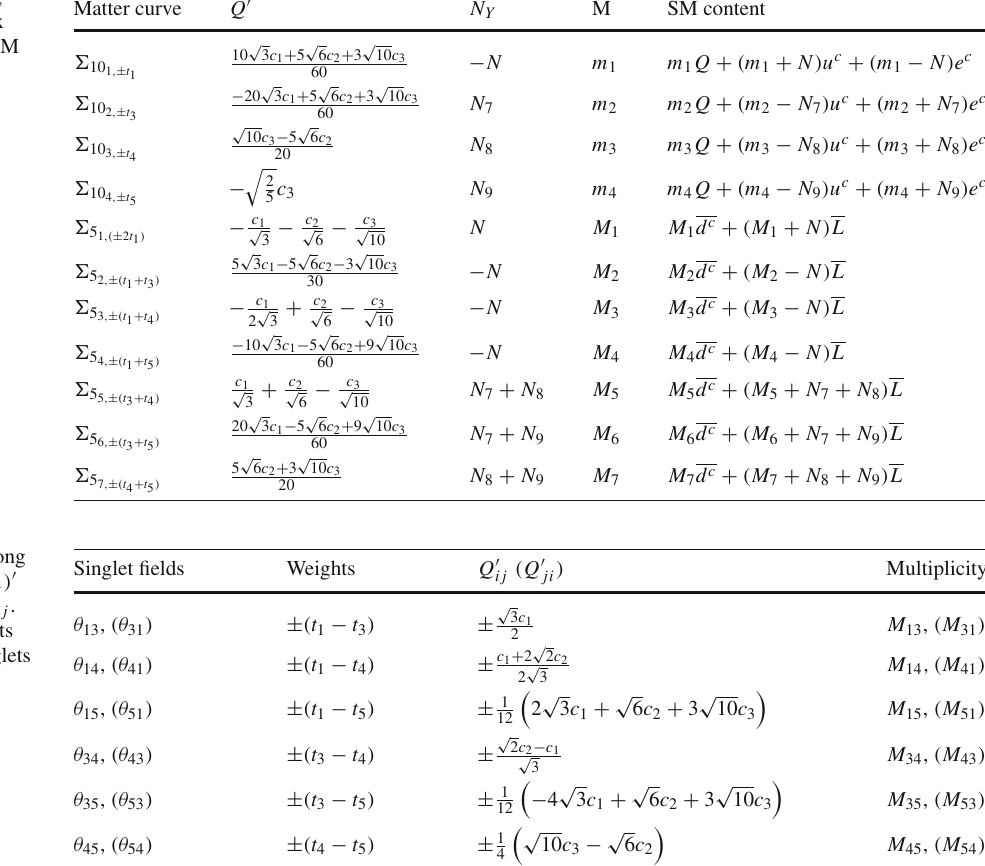
Table 3 Matter curves along with their U ( 1 ) (cid:2) charges, flux data and the corresponding SM content. Note that N = N 7 + N 8 + N 9